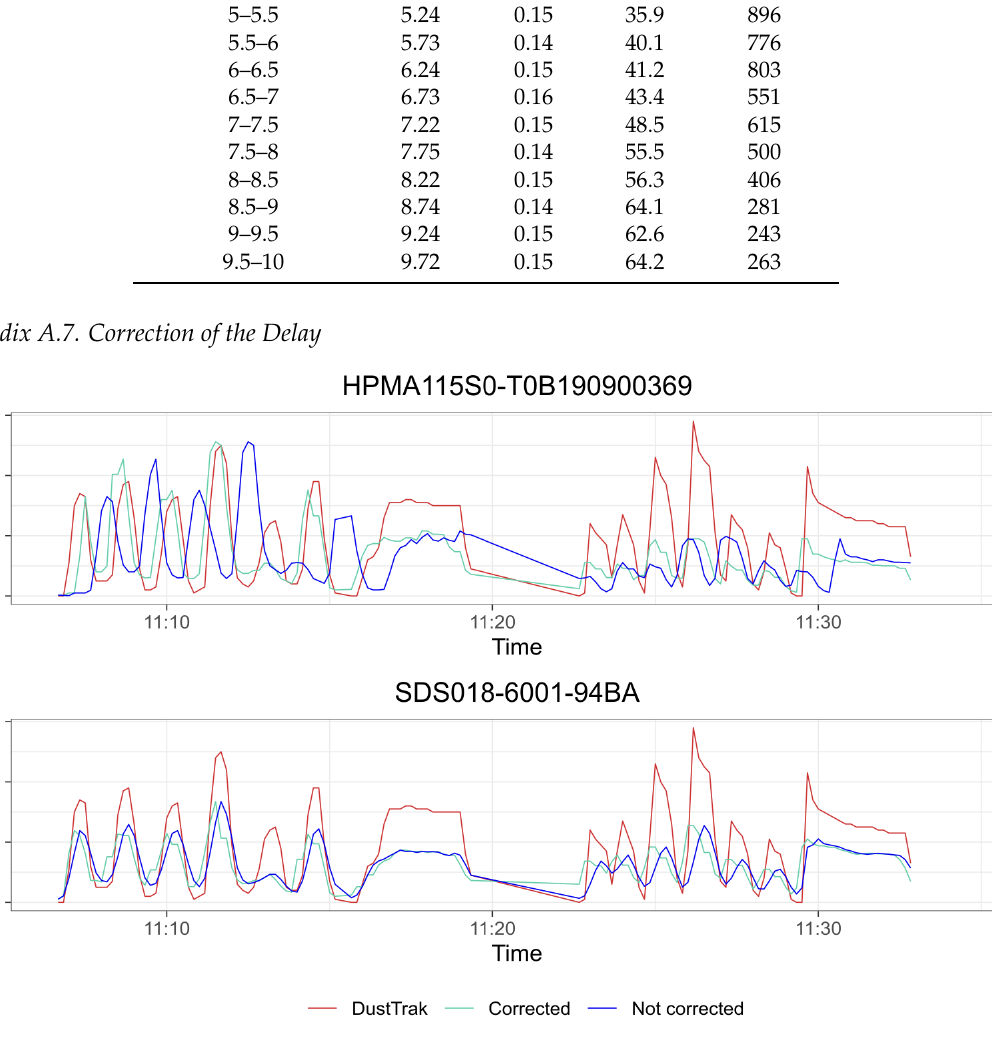
Figure A14. Example of the results of the Derivative Dynamic Time Warping method applied to one HPMA115S0 and one SDS018 during experiment